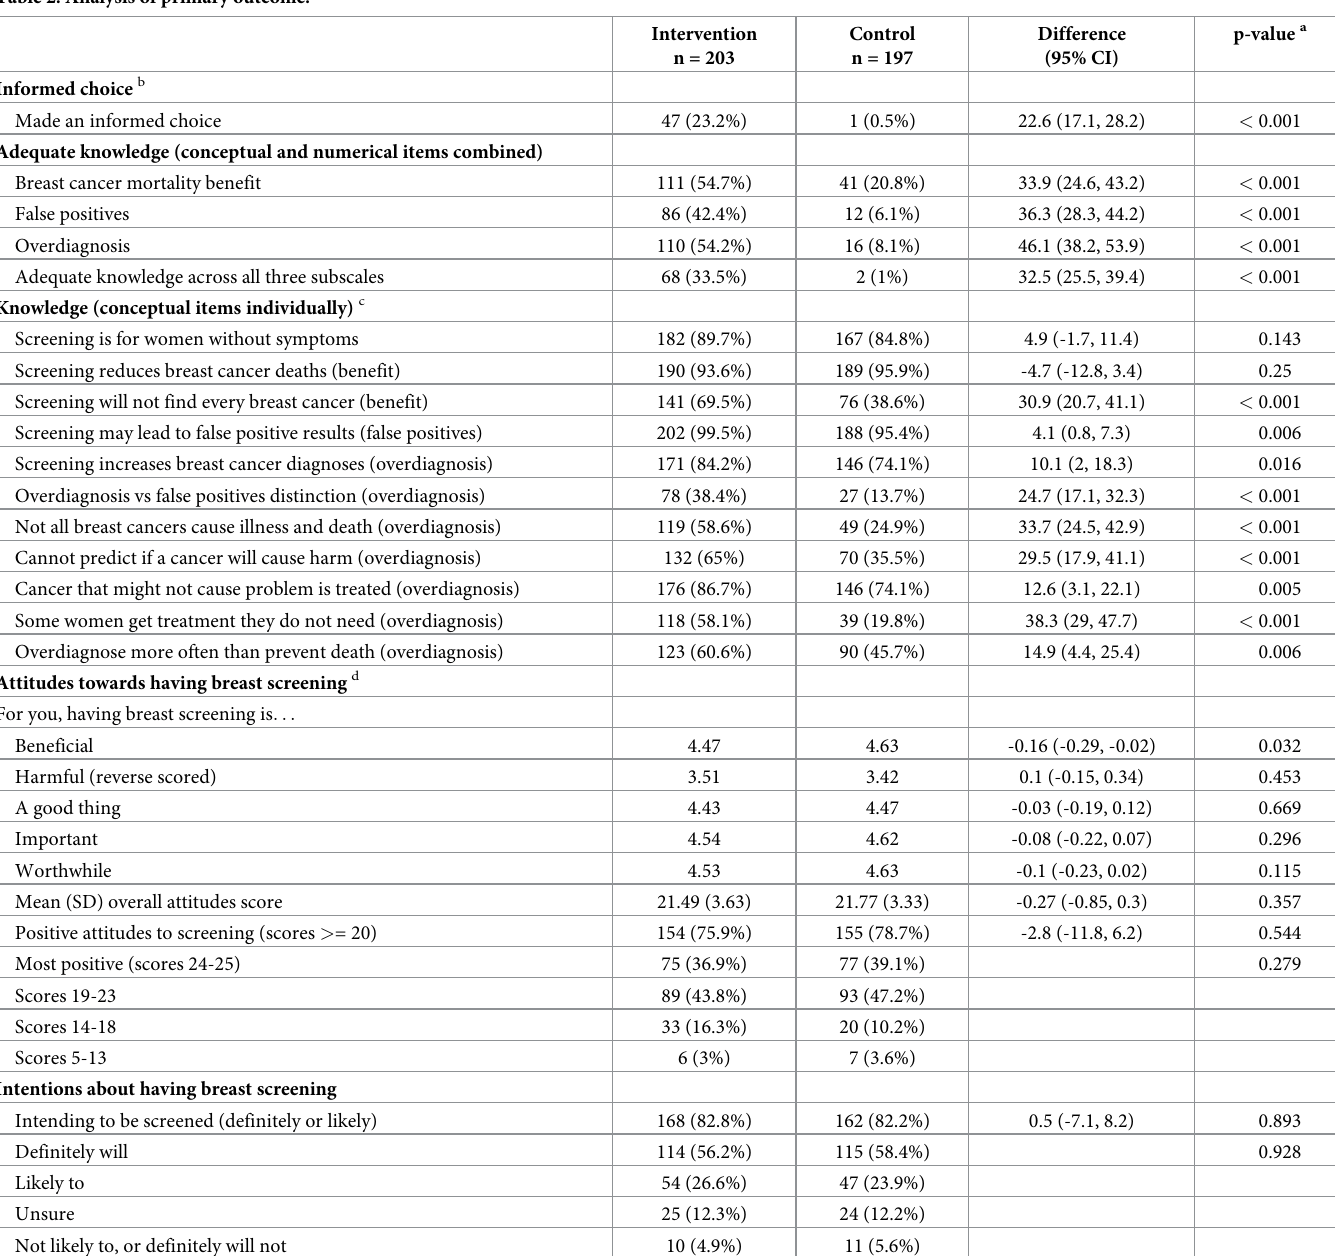
Table 2. Analysis of primary